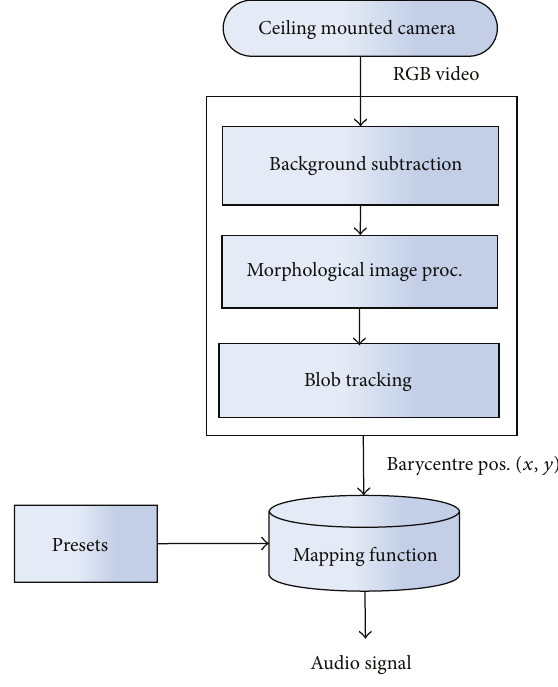
Figure 8: The Harmonic Walk ’s system